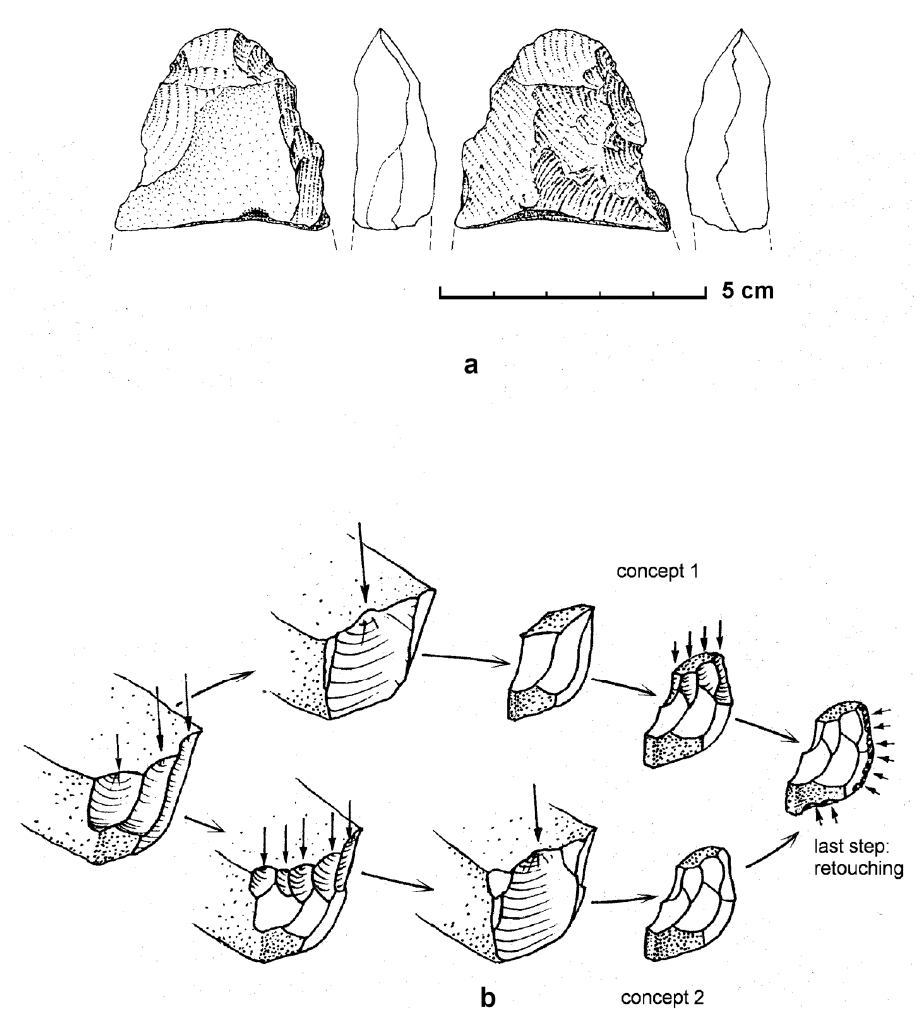
Figure 15. Dorn-Dürkheim 3. ( a ) A bifacially worked artefact made out of `basalt´, ( b ) two different ways of working out the scraper (with dorsal reduction on the core or later reduction on the flake). (After Fiedler and Franzen 2002.).